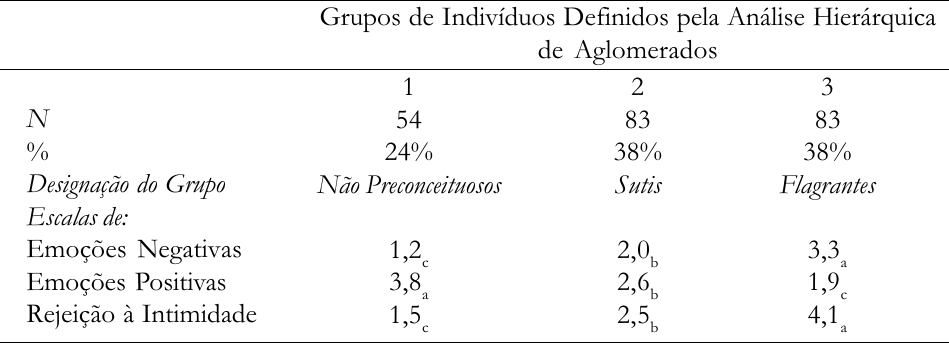
Tabela 4. Freq(cid:252)Œncias, Porcentagens e MØdias da Adesªo dos Grupos de Estudantes que Foram Definidos pela AnÆlise HierÆrquica de Aglomerados nas Escalas de Expressªo Emocional e Rejei(cid:231)ªo (cid:224) Intimidade em Rela(cid:231)ªo aos Homossexuais